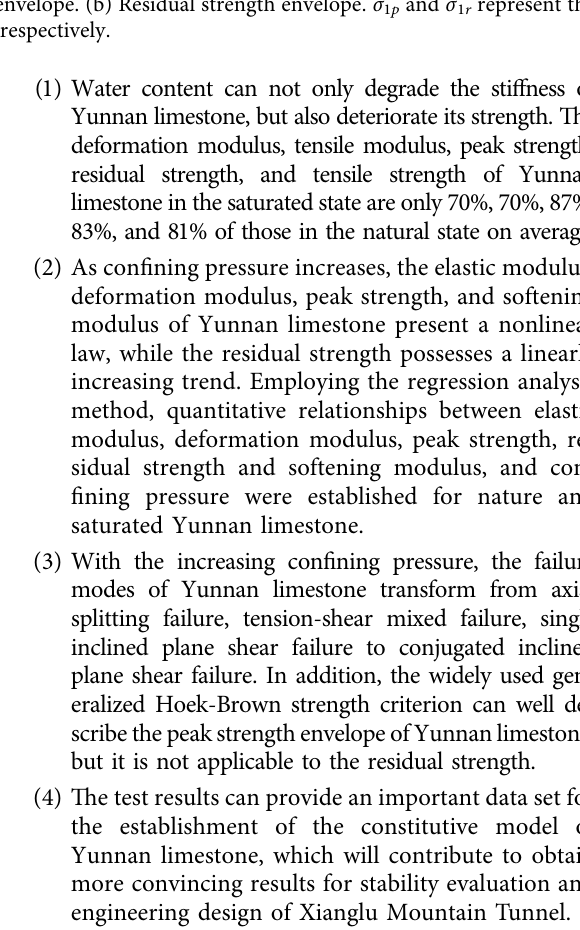
1 p and σ 1 r represent the